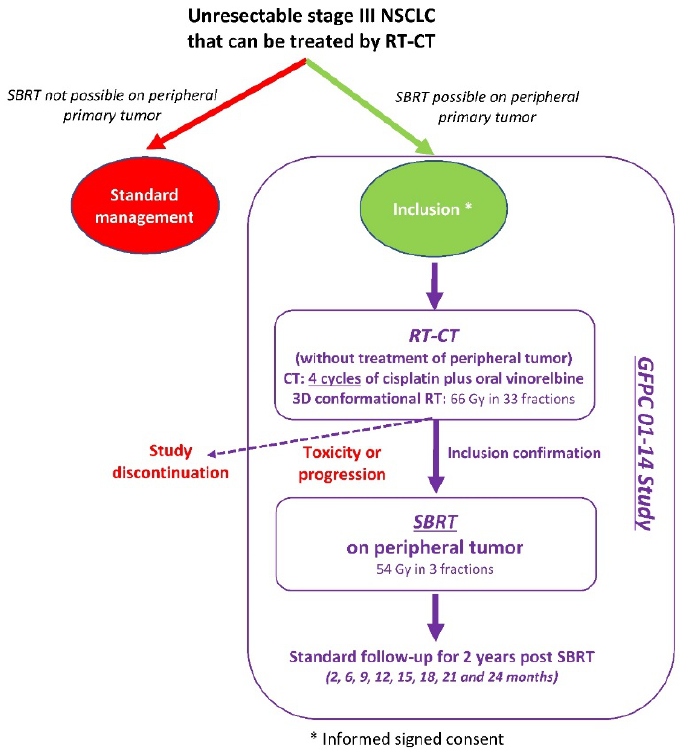
Figure 1. Study Figure 1. Study design.